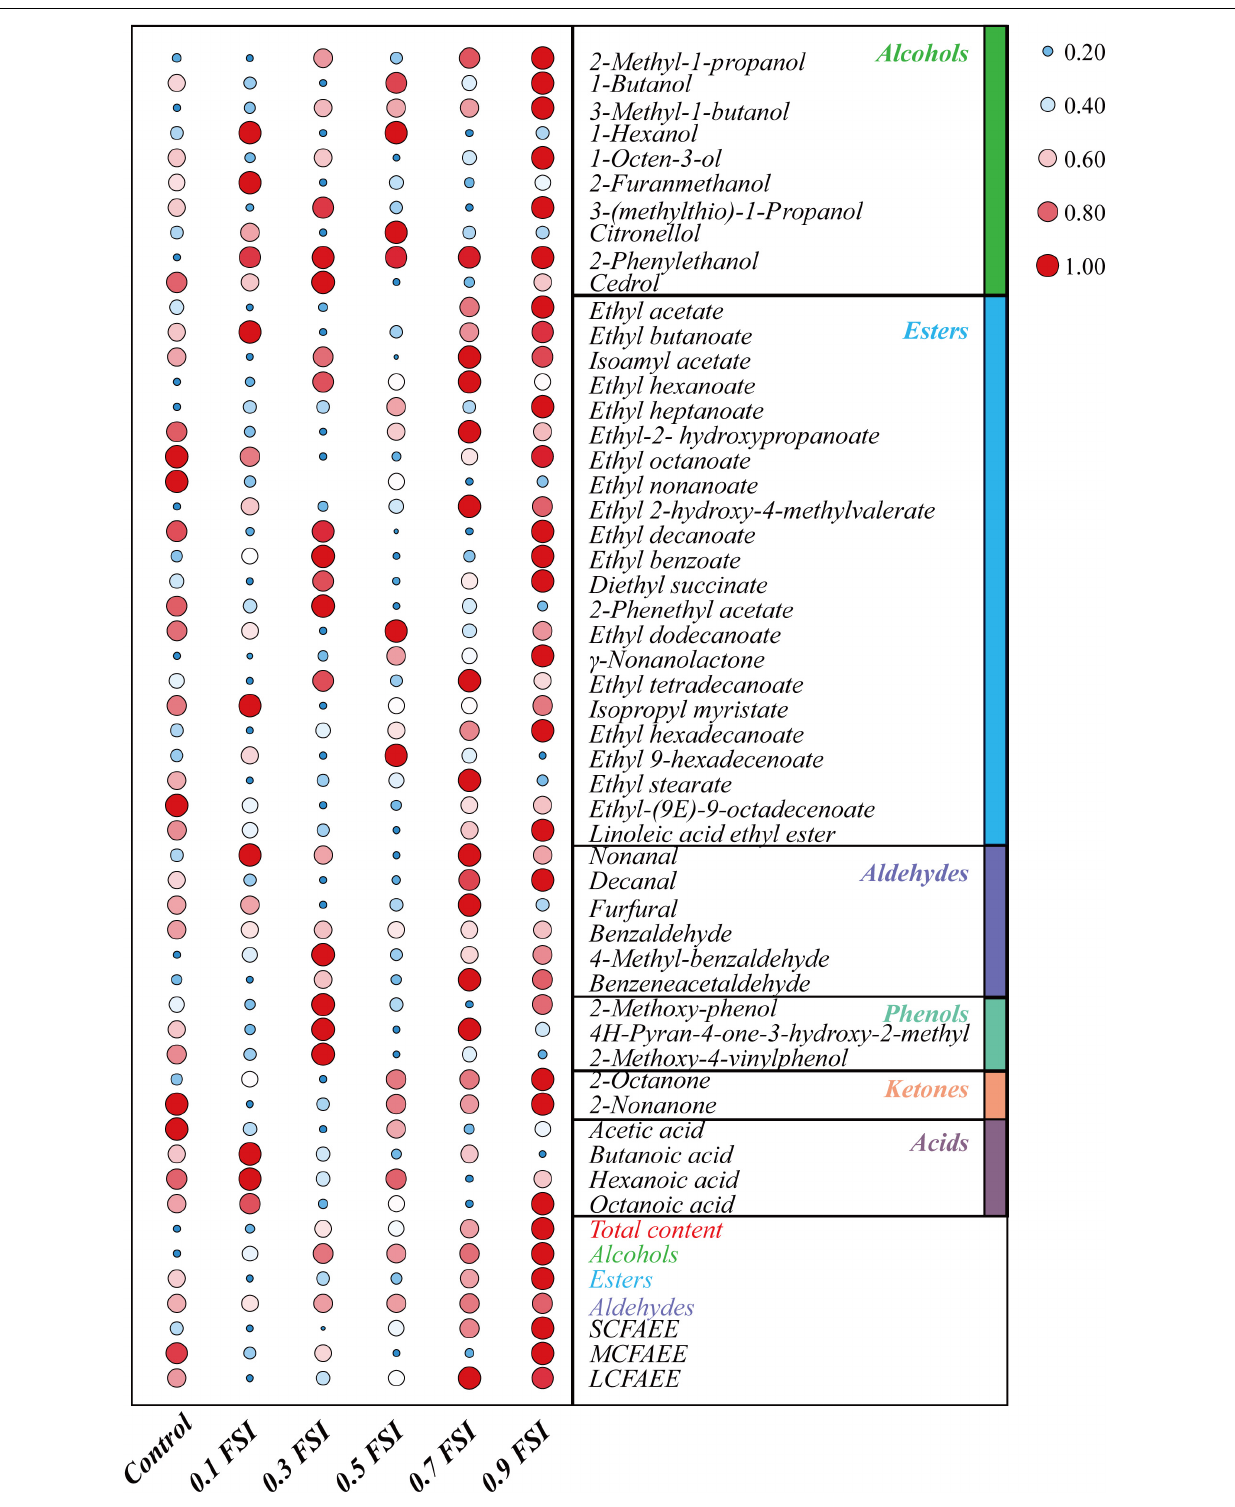
Frontiers in Microbiology |